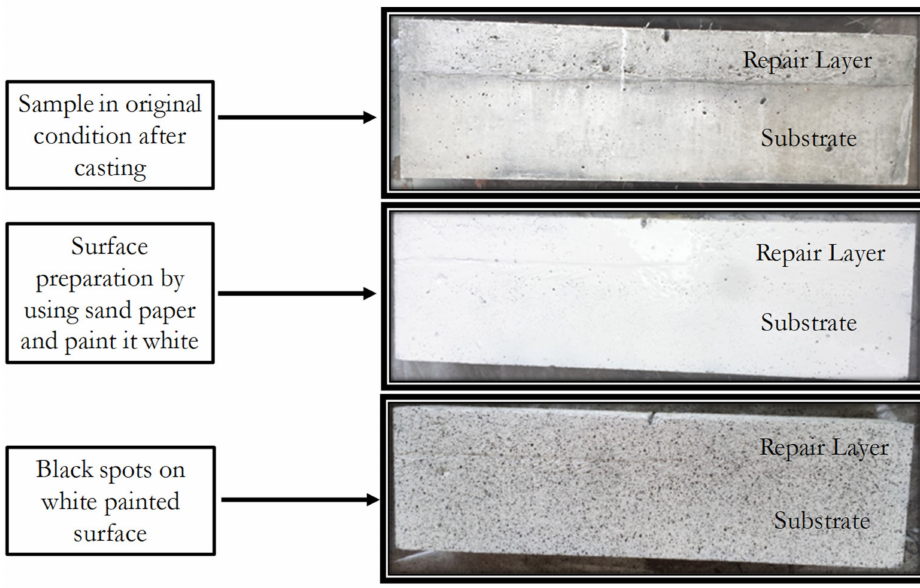
Figure 7. Surface preparation of specimen for the bending test along with DIC technique.